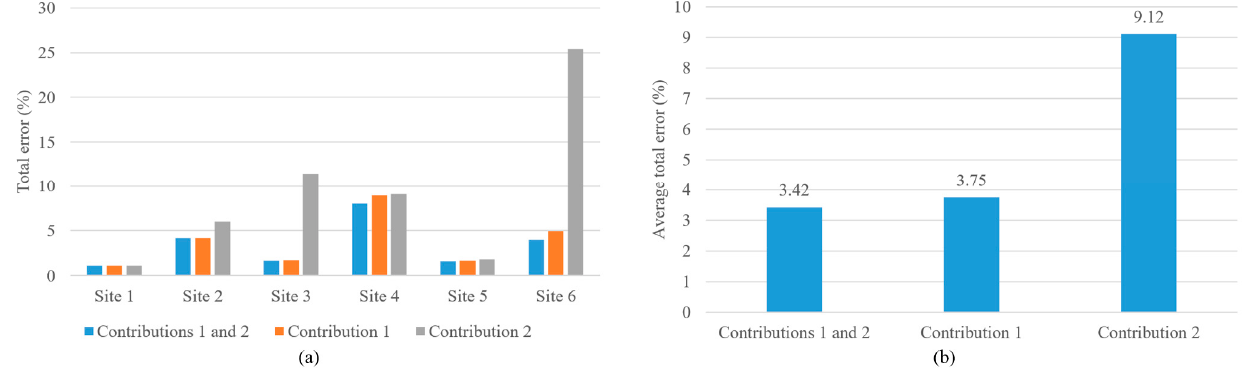
Figure 16. Accuracy comparison of the proposed method with and without each contribution in terms of ( a ) each forested site and ( b ) their average values. terms of ( a ) each forested site and ( b ) their average